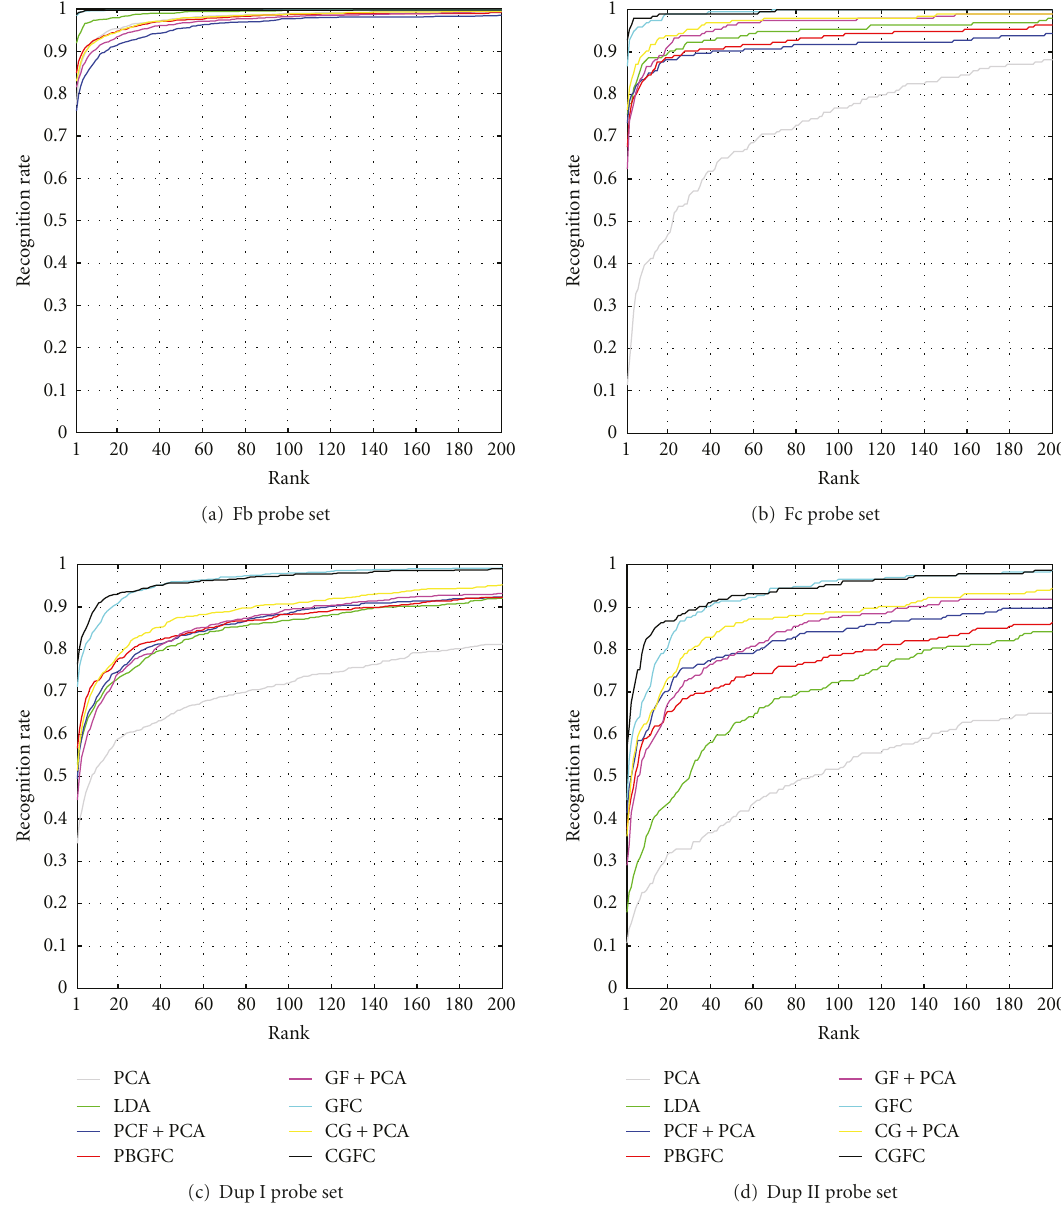
Figure 20: CMC curves obtained with di ff erent probe sets of the FERET database.